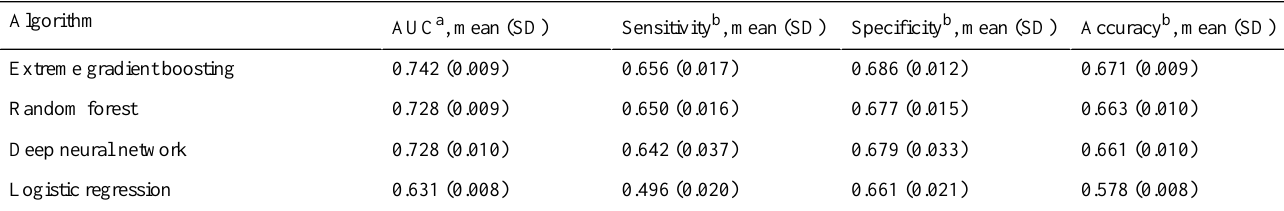
Table 3. Performance of the four machine learning algorithms on predicting breast cancer